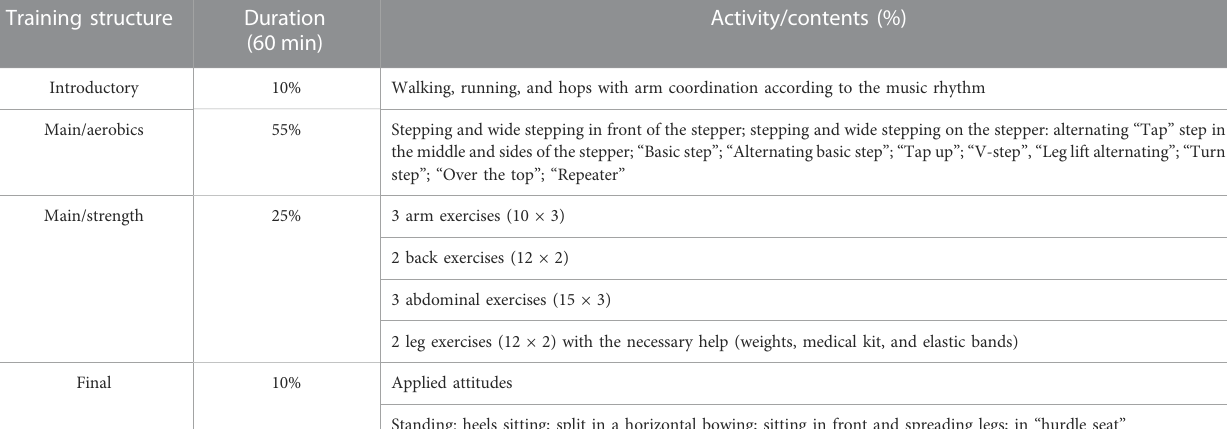
TABLE 1 Training